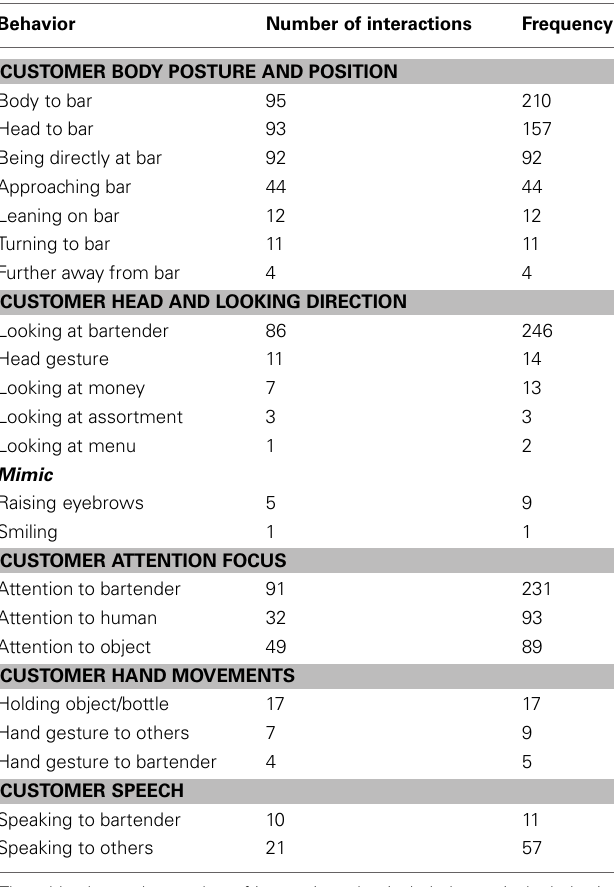
Table 1 | Summary of customer behavior when bidding for